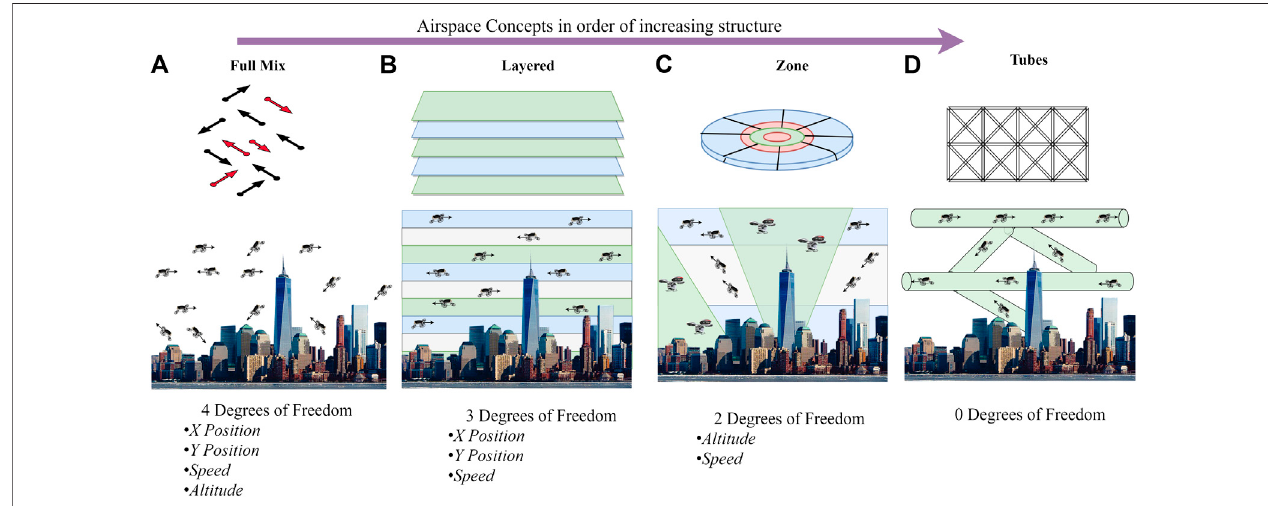
FIGURE 2 | Different airspace concepts in order of increasing structure: (A) Full Mix, (B) Layered, (C) Zone and (D) Tubes.